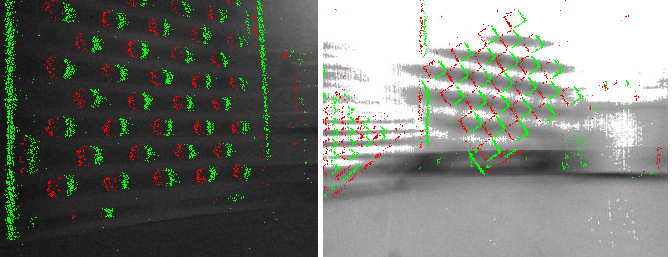
Figure 7. Challenging illumination conditions . Regular frames suffer from poor contrast ( left ) when lights are off or motion blur ( right ) when lights are on, which is caused by inappropriate exposure time under varying illumination conditions. Events, in turn, preserve the visual information of the